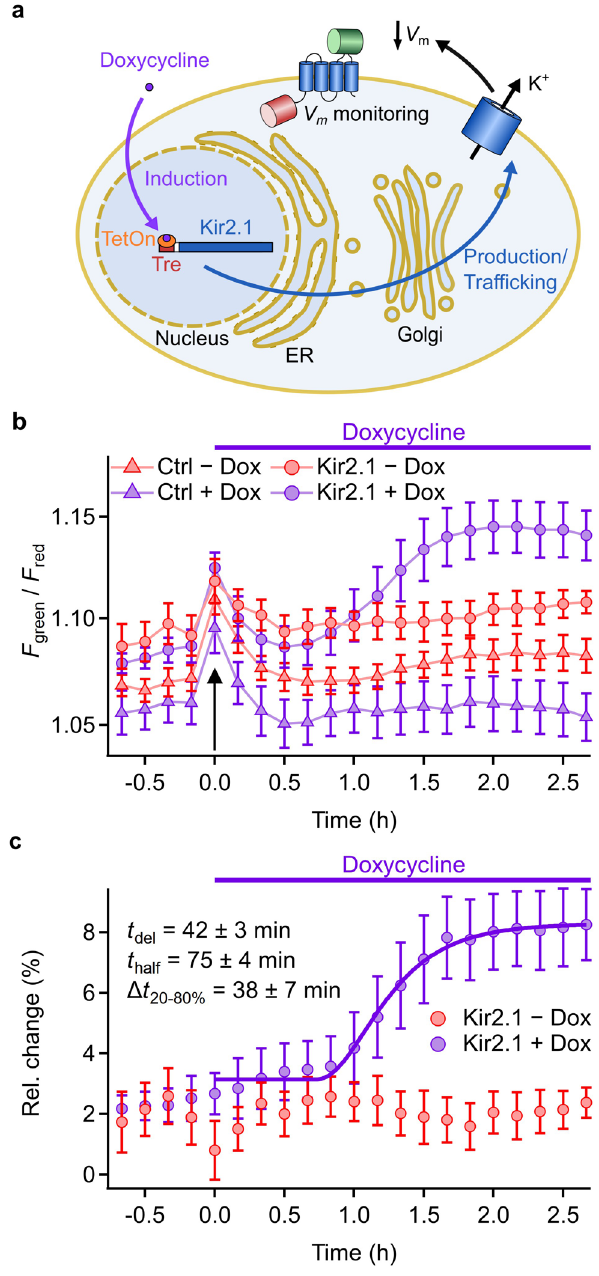
Fig. 5 Time course of cell hyperpolarization induced by triggered expression of Kir2.1. a Schematic of measurement of production speed of functional Kir2.1 channels using ratiometric GEVIs as V m monitor. GEVIs are constitutively produced from an expression vector with CMV promoter. Kir2.1 expression is controlled by the Tre/TetOn system, which is triggered by the application of doxycycline. b Time course of F green / F red of HEK293T cells transfected with rASAP and a doxycycline-inducible expression vector system. Gene expression of Kir2.1 or Ctrl (empty pDox vector) with 200 ng/ml doxycycline (Dox) was induced as indicated (purple symbols). Application of solution induced a transient increase of F F green / red in all samples (black arrow). Under control conditions (red symbols), the same application handling was performed without Dox. Images were acquired every 10 min. DMEM-F12 cell culture medium was exchanged with FluoroBrite DMEM 13 h before doxycycline application. Values are means ± sem of images from four different locations in one cell- culture dish. c Relative change in F green / F red , normalized to the respective control, as a function of time. The solid curve for the Dox-induced data is a fi t according to Eq. 5, resulting in 5.1% maximal relative change and the indicated kinetic